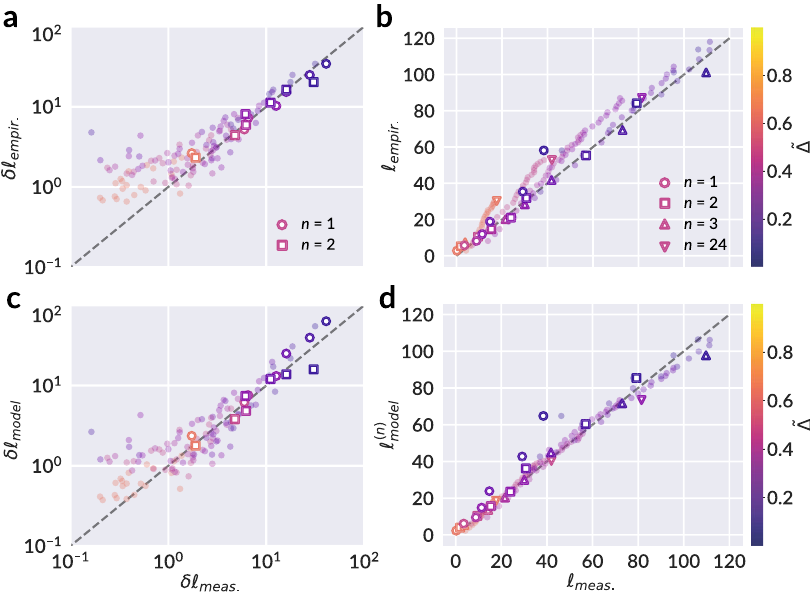
Fig. 7 Validation of empirical and derived models for crease length evolution with measurement. a Predicted change in total crease length δ ℓ empir. given (cid:2) ‘ ð n (cid:2) 1 Þ by Eq. (12) plotted against the measured change in crease length between two successive crumples, δ ‘ meas : (cid:3) ‘ ð n Þ . Open markers correspond to meas : meas : manually segmented data consistent with prior results presented in this work, while fi lled circles correspond to data which was processed using the automated segmentation as detailed in the Supplementary Methods. A 1:1 reference line (dashed) is provided as a guide to the eye. b The total crease length ℓ empir. given by Eq. (11) plotted against the measured total crease length ℓ meas. . c The change in total crease length δ ℓ model as predicted by Eq. (20), obtained from Eqs. (14) and (21), against their corresponding measured values, in direct comparison to a and b . Marker and d the total crease length ‘ ð n Þ model colors in all panels correspond to different values of ~ Δ , as indicated by the colorbar. We see that both the empirical and derived relations for δ ℓ and ℓ serve as strong models of measured data, and af fi rm the suitability of a logarithmic relationship to describe damage evolution in this